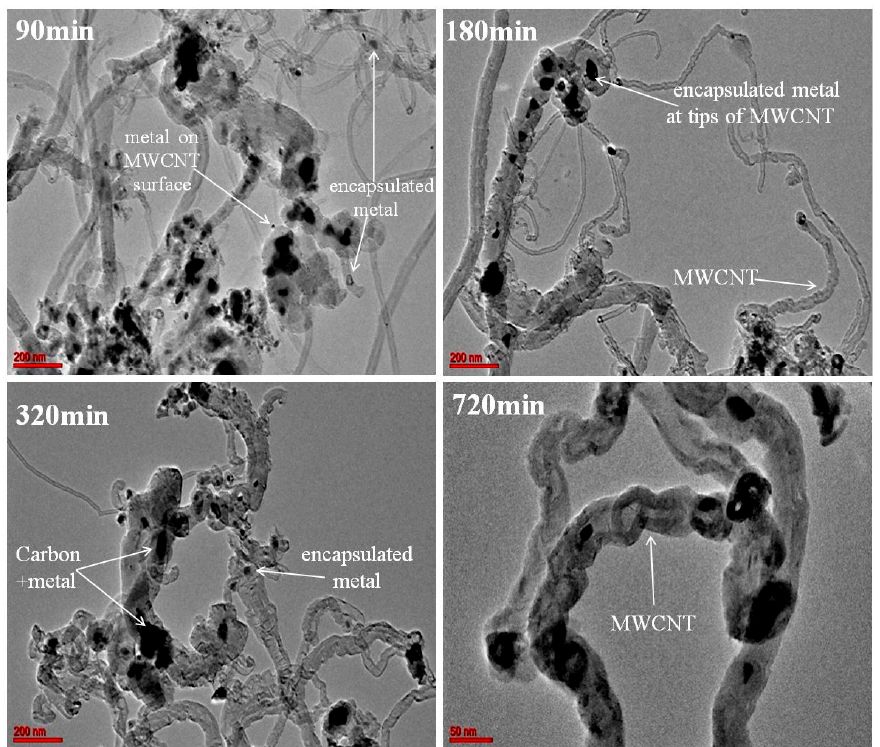
Figure 2. Top surface transmission electron microscopy (TEM) micrographs of spent and spent/regenerated 15Co–30Fe/Al 2 O 3 catalysts obtained after different times (90, 180, 320, and 720 min).